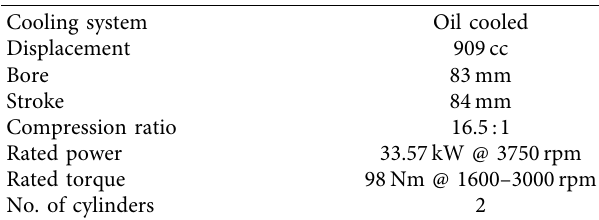
Table 1: Engine specifcations.